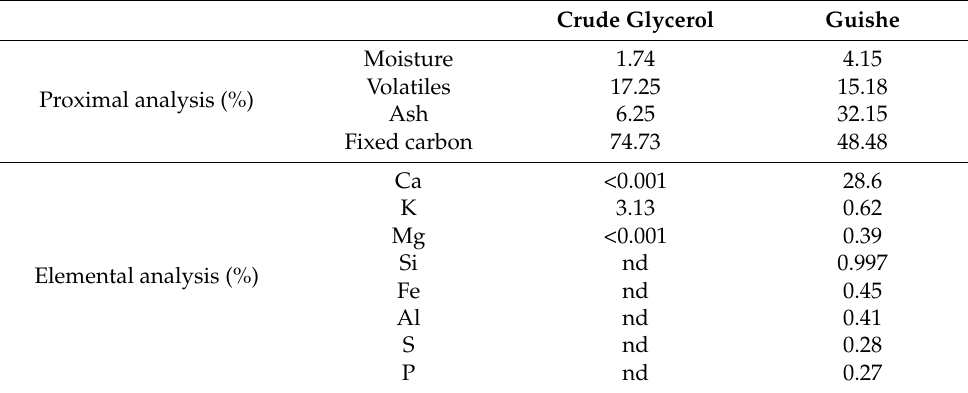
Table 1. Proximal and elemental analysis of CG and GI.